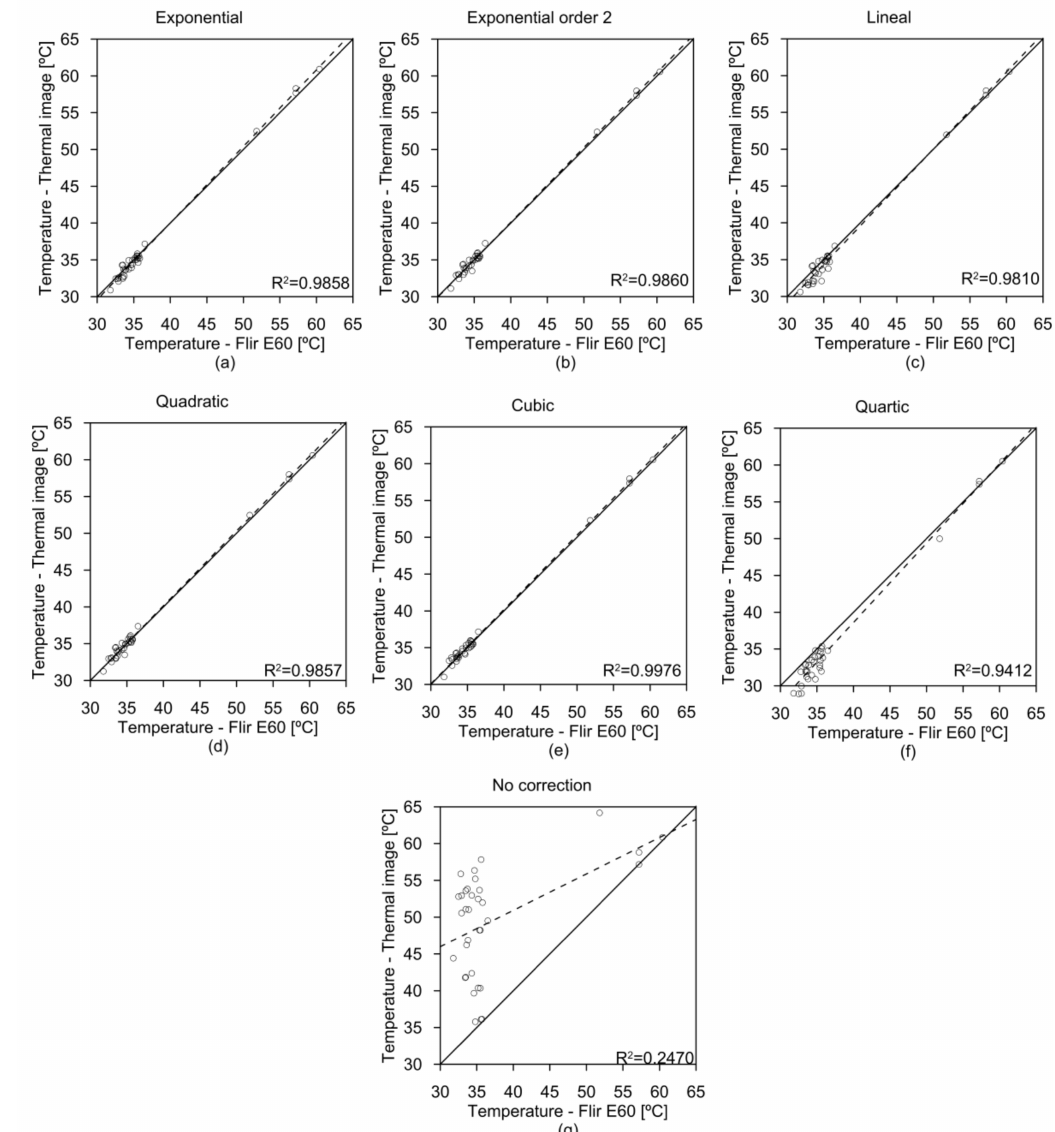
Figure 7. Correlation for each drift correction model (DCM) between temperature values from the thermal orthomosaic and on-ground measurement at 16:30 p.m. unmanned aerial vehicle (UAV) flight.